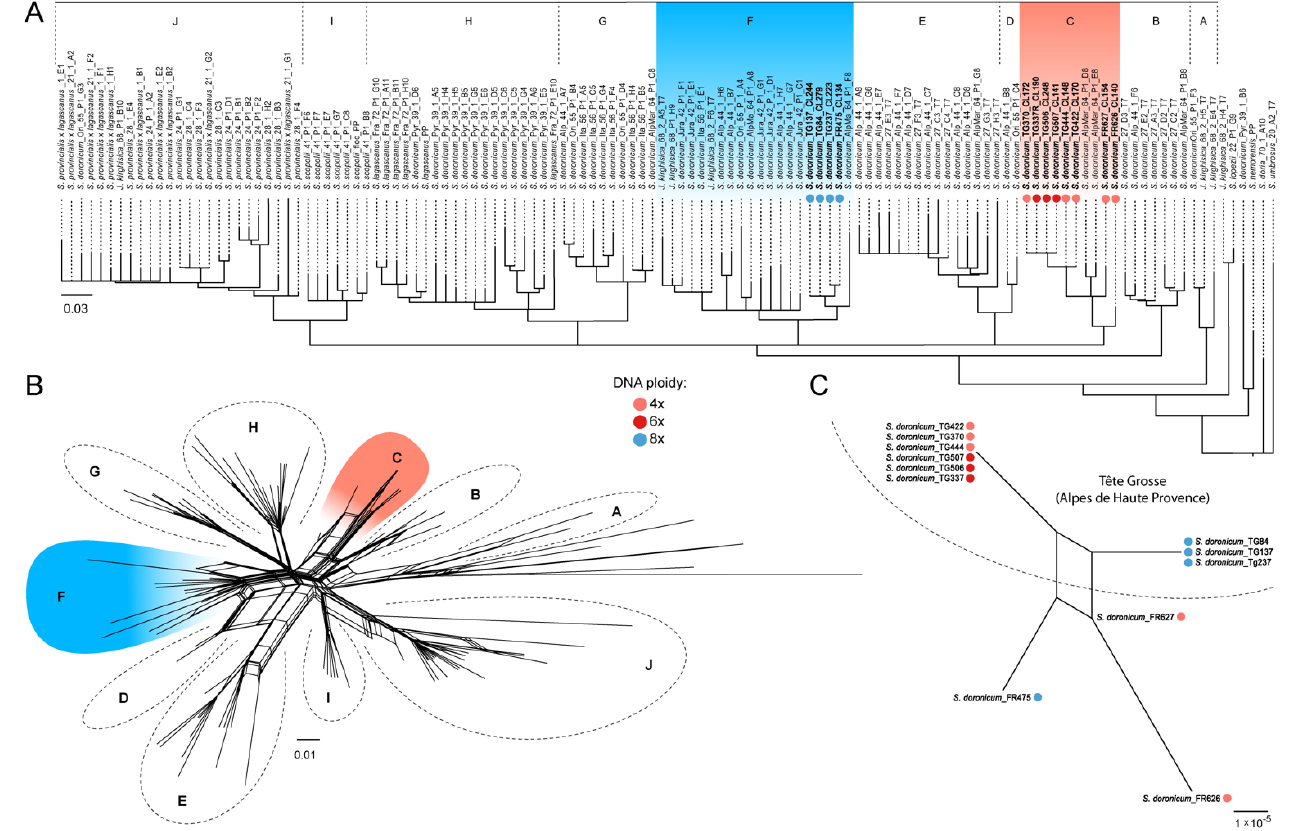
Figure 5. Neighbour joining tree ( A ) and Neighbour net analysis ( B ) based on ITS sequences of European clade of Senecio sect. Crociseris from Calvo et al. [34], and including 4x, 6x and 8x individuals of Senecio doronicum from the present study. ( C ) Neighbour net analysis of whole plastid sequences among those same individuals sequenced in our study. Dashed line separates individuals of Tête Grosse from other populations in the area. Capital letters indicate genetic